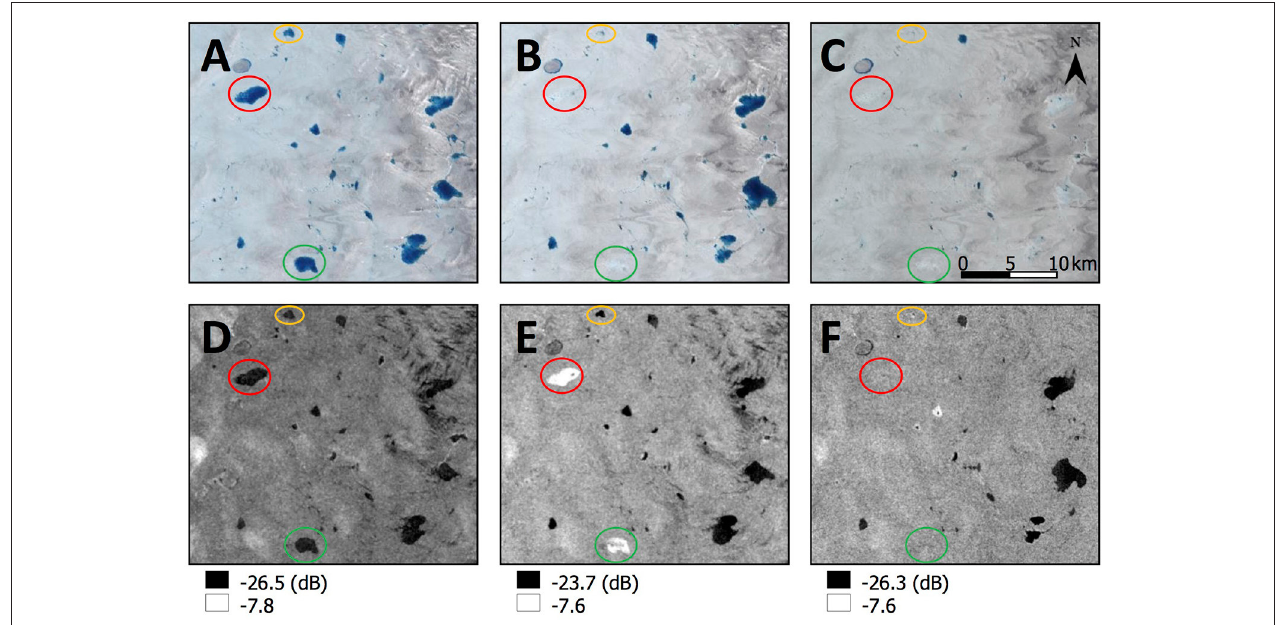
FIGURE 3 | Example surface lake drainage events in Landsat RGB false-color imagery (A–C) and Sentinel-1 HH polarization (D–F) ; location within the study region is shown in Figure 1 . Image (A) was acquired on day 189, (B) on day 196, (C) on day 212, (D) on day 188, (E) on day 190, and (F) on day 200 (all 2015). The yellow circles indicate a “standard” drainage event; the green and red circles highlight two lakes that drain with an intermediate stage observed in the Sentinel-1